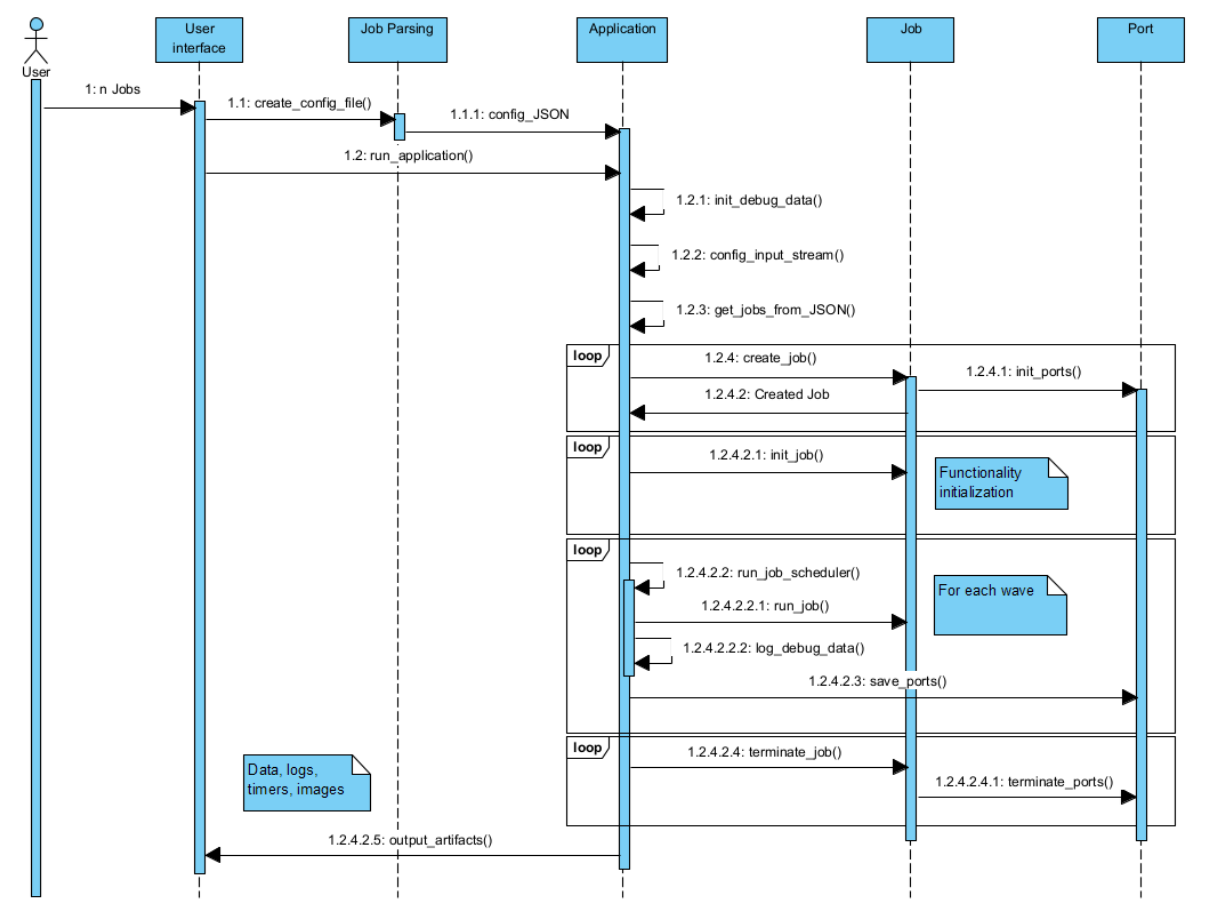
Figure 8. EECVF application block sequence